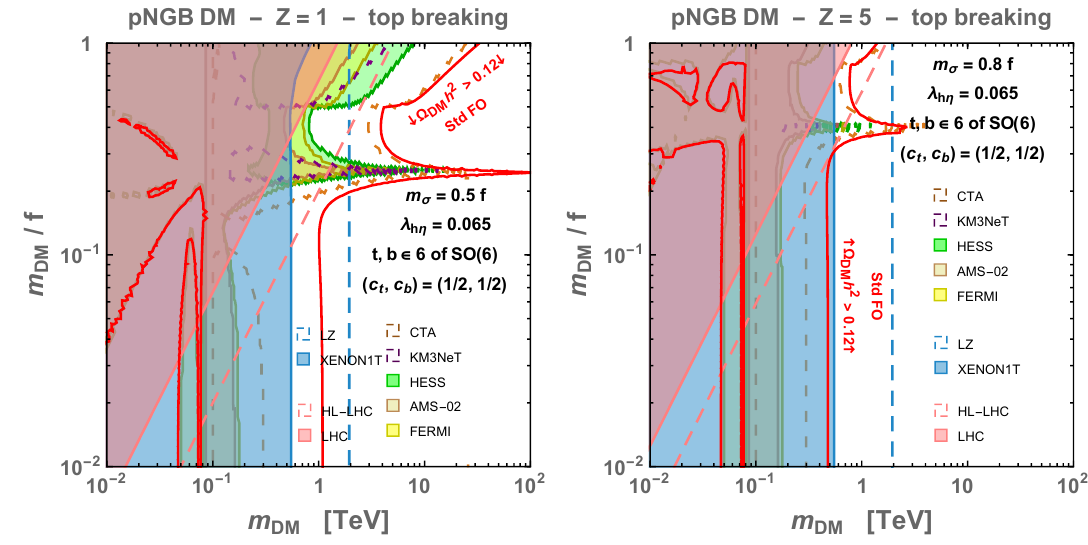
Figure 4 . Dilaton-mediated O(6)/O(5) pNGB DM in the standard freeze-out case . Lines and shadings as in figure 3. The constants c and c are defined in eq. (3.7). In addition to the dilaton b t channel, pNGB DM is coupled to the SM through the composite Higgs interactions, cf. section 3.1, which lead to a non-trivial behaviour of the red thermal relic abundance contours. We can see a horizontal resonance around m ’ m σ / 2 , a vertical resonance around m ’ m h / 2 and a broad DM DM funnel in the [80 GeV , 1 TeV] or [80 GeV , 500 GeV] region due to efficient annihilation into WW , ZZ , hh and tt . In figure 14, we also show the pNGB DM scenario where the shift symmetry is broken by the bottom quark instead of the top quark, such that the Higgs-DM mixing is reduced to λ h η ’ 0 . 065 → 10 − 4 , cf. section